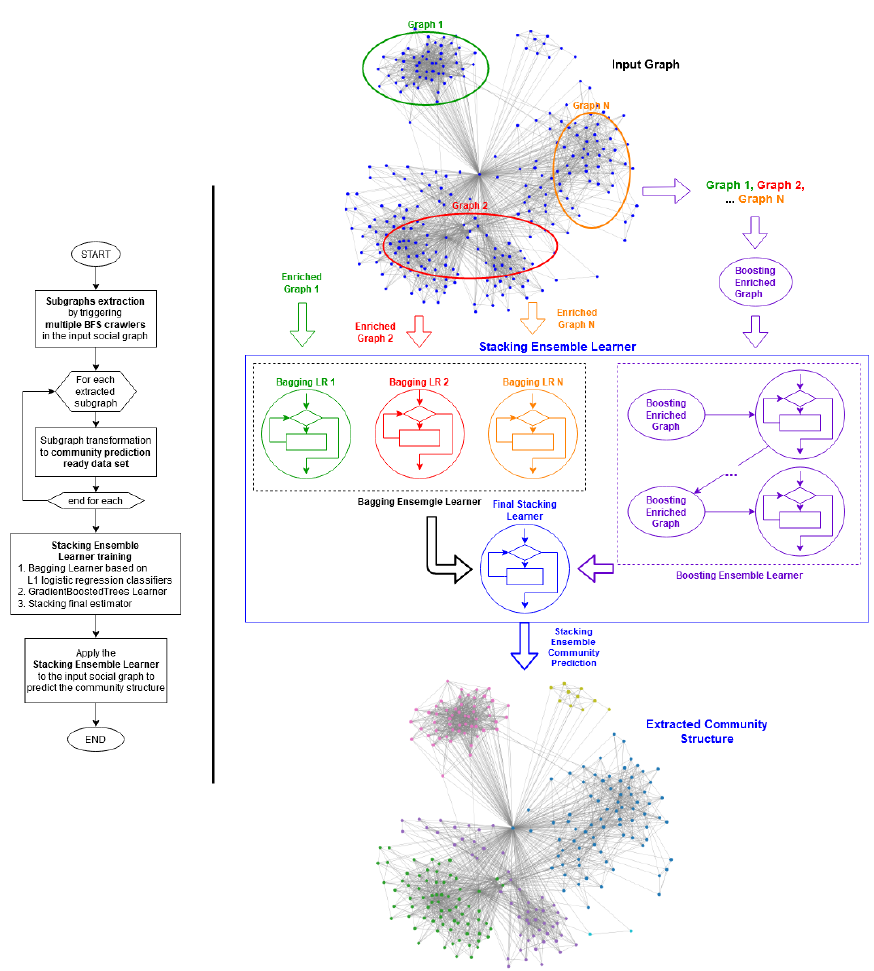
Figure 1. The flowchart and the diagram of the stacking ensemble prediction